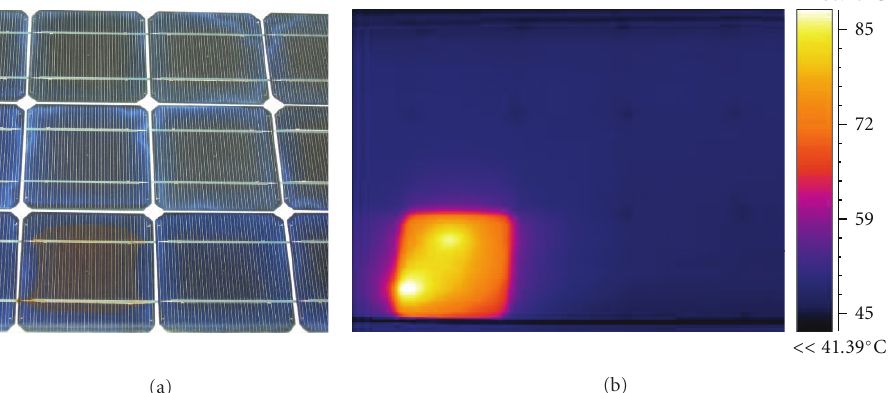
Figure 4: (a) Digital and (b) IR image, of browned cell and neighboring cells. IR image reveals two hot spots at the severely browned cell.